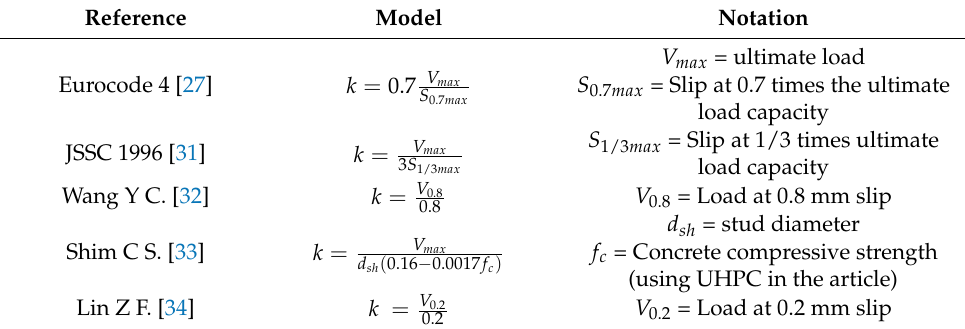
Table 4. Typical formulae for shear stiffness of stud